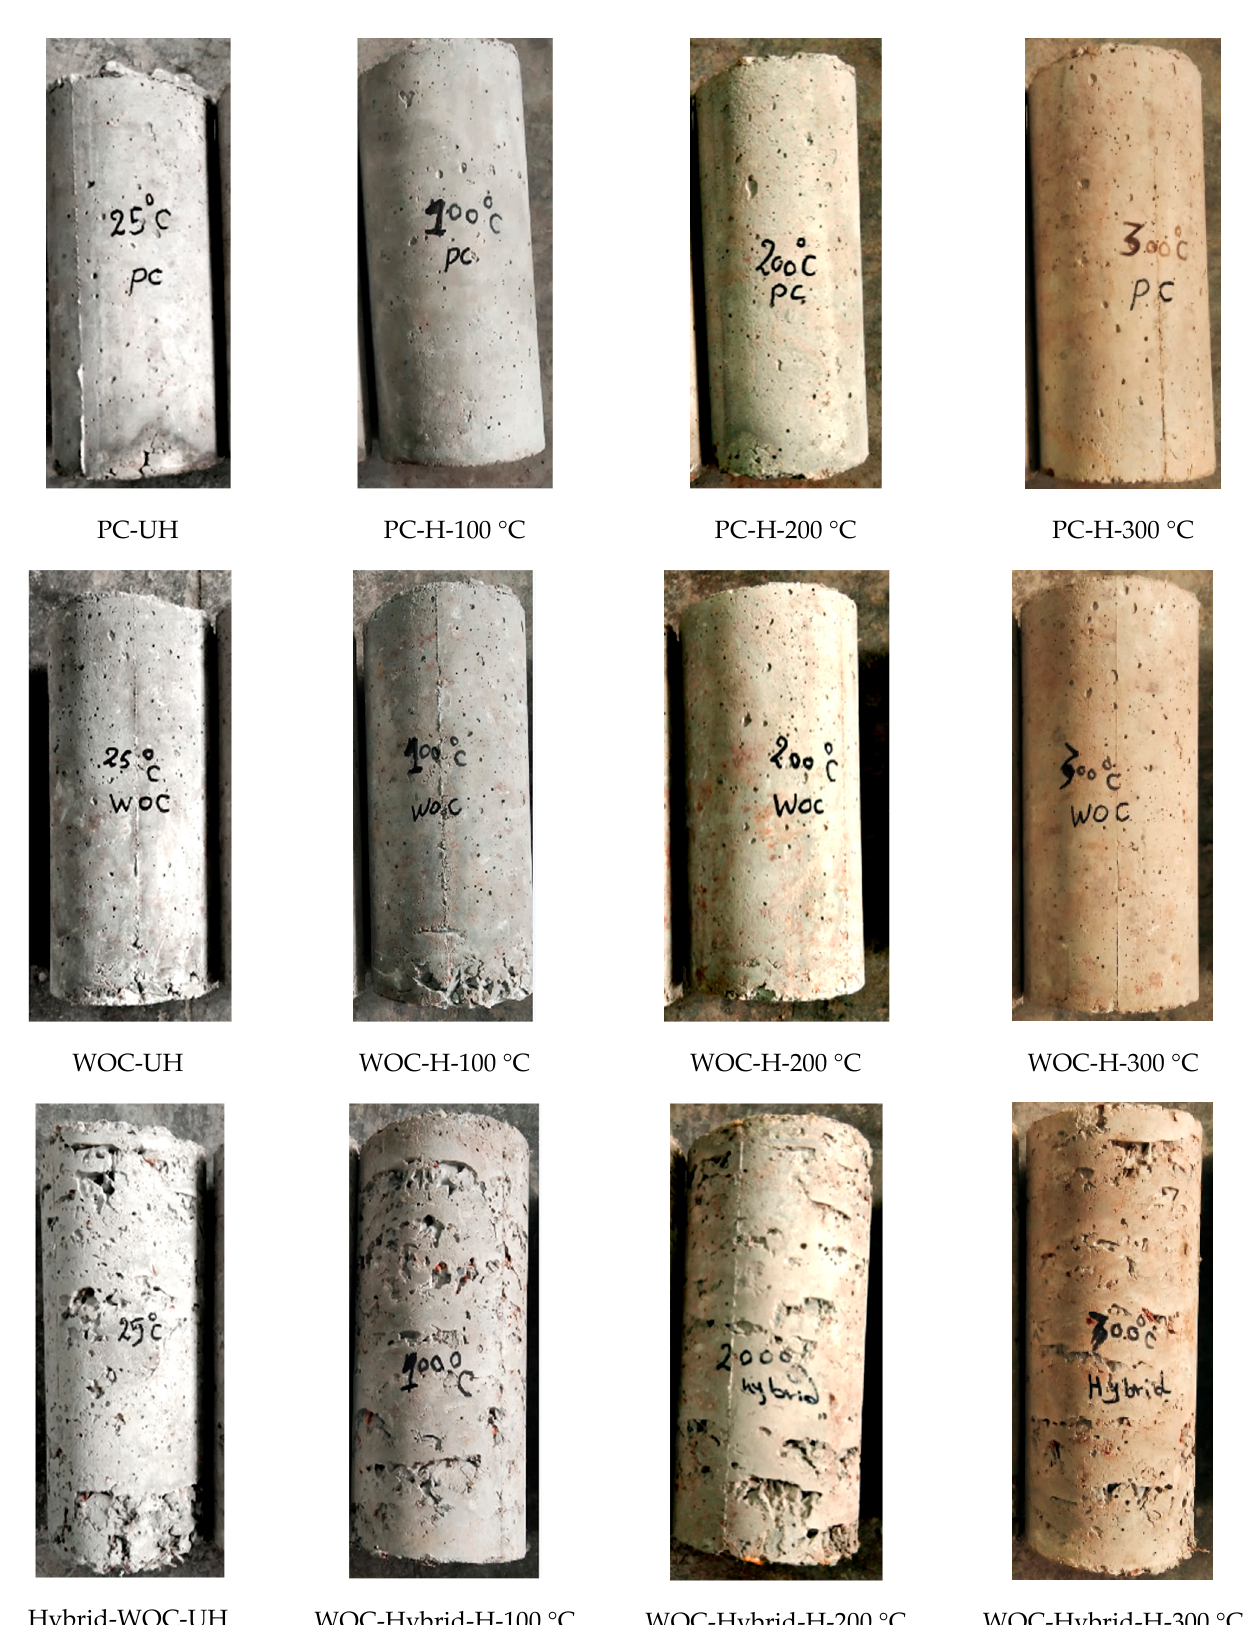
Figure 8. PC, WOC, and WOC-Hybrid specimen colour after being exposed to 100 °C, 200 °C, and 300